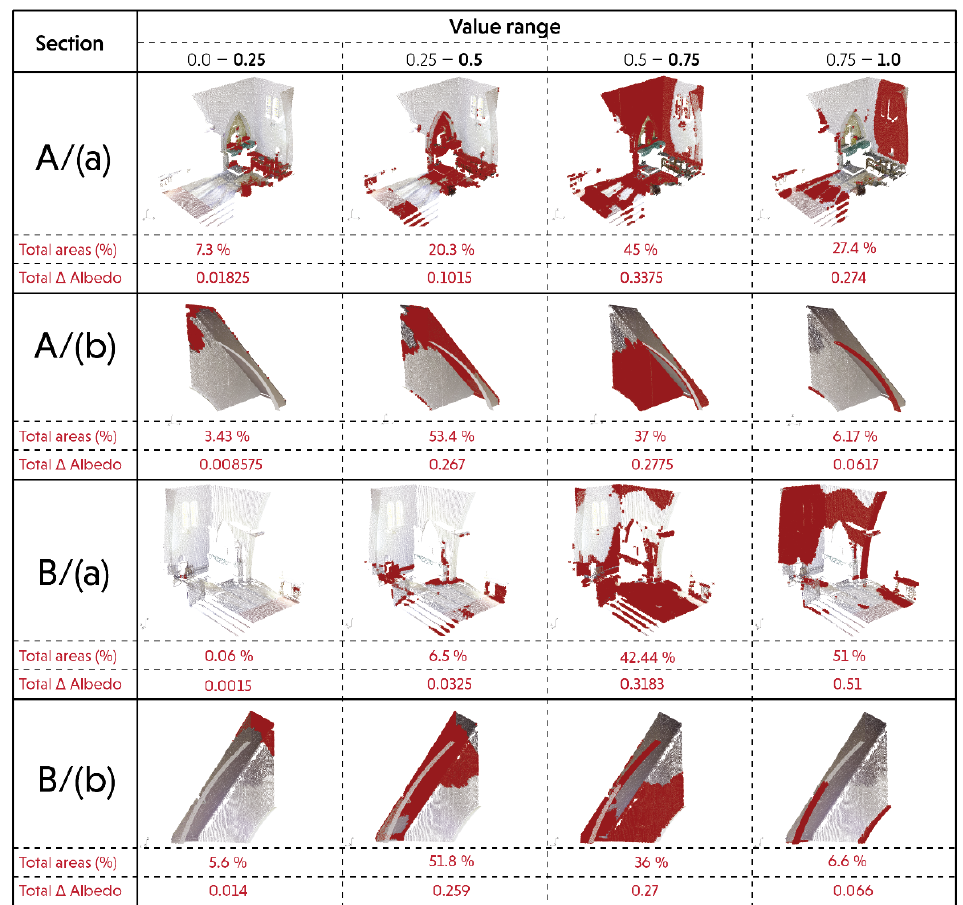
Figure 8. The total ( ∆ ) albedo of each section of the dataset. A /( a ) Fracture zone–North wall; A /( b ) Fracture zone–North roof; B /( a ) Fracture zone–South wall; B /( b ) Fracture zone–South roof.